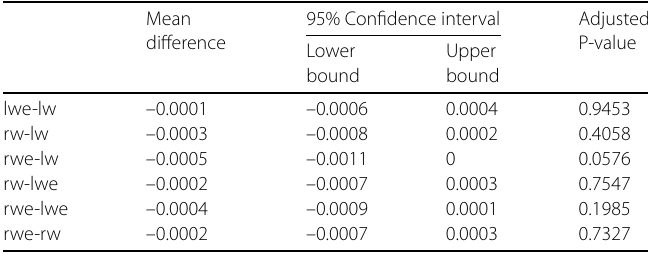
Table 16 ANOVA results to test for correlation of political orientation and extremity with text-based indicators of ingroup loyalty Degree of Sum of square Mean square F value Pr (> F ) freedom Political orientation 1 0.00000004 0.00000004 3.651 0.056 Political extremity 1 0.00000006 0.00000006 6.056 0.014 ∗ Residuals 19,997 0.00018303 0.00000001 –